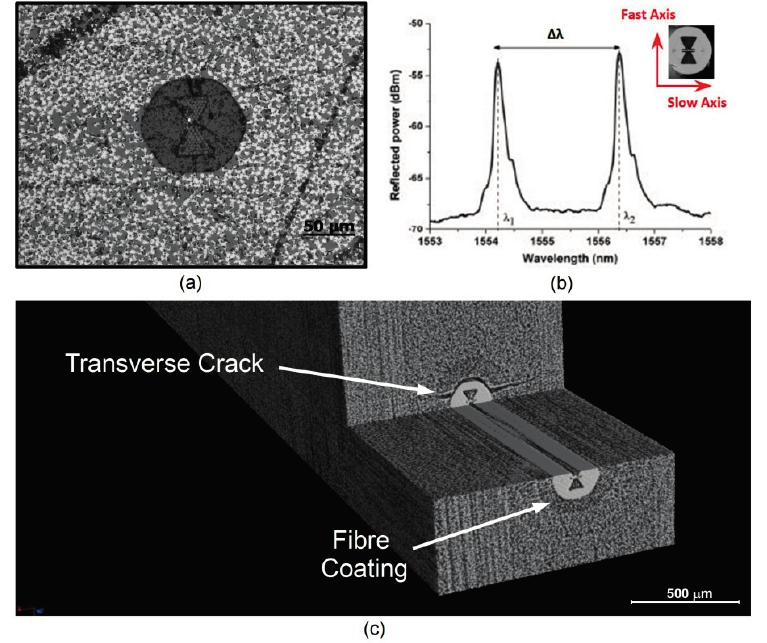
Figure 6. ( a ) Polished cross-section obtained by optical microscopy (0.8× to 20×) for